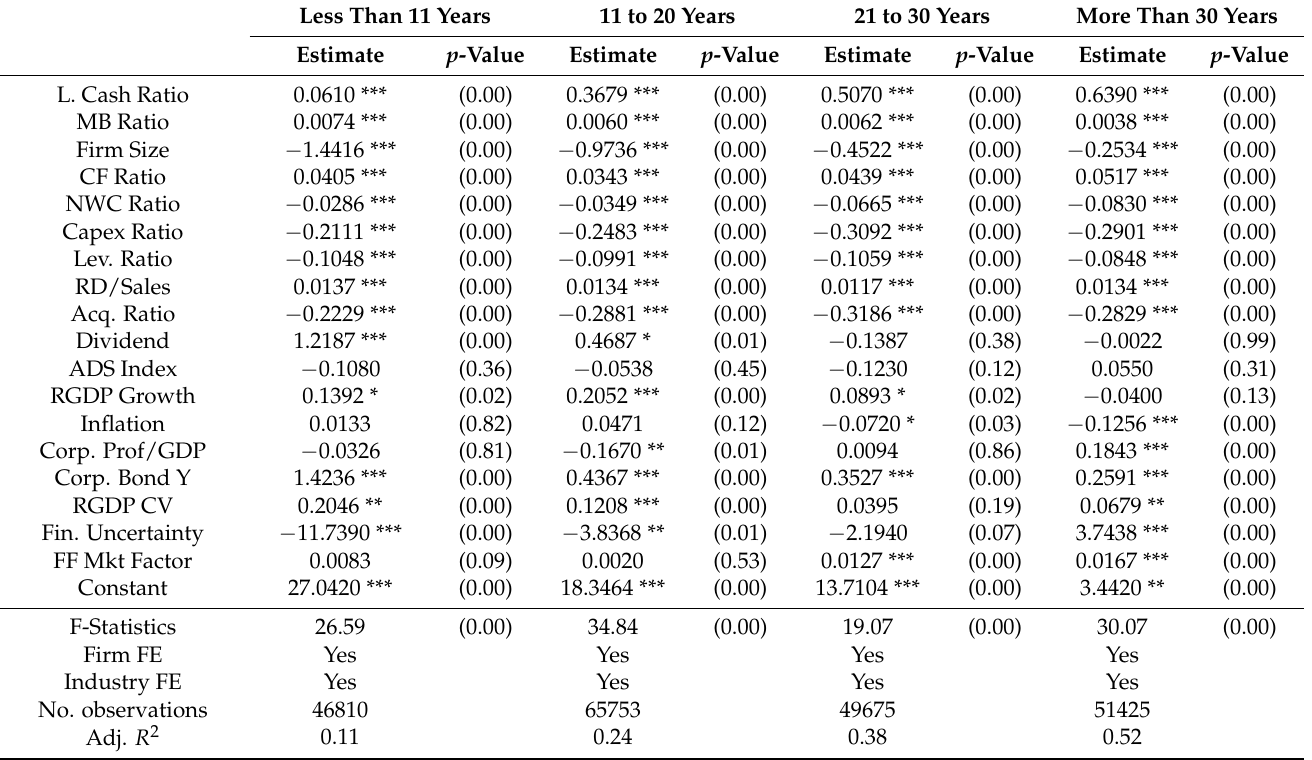
Table 5. Fixed-Effects Estimates by Age